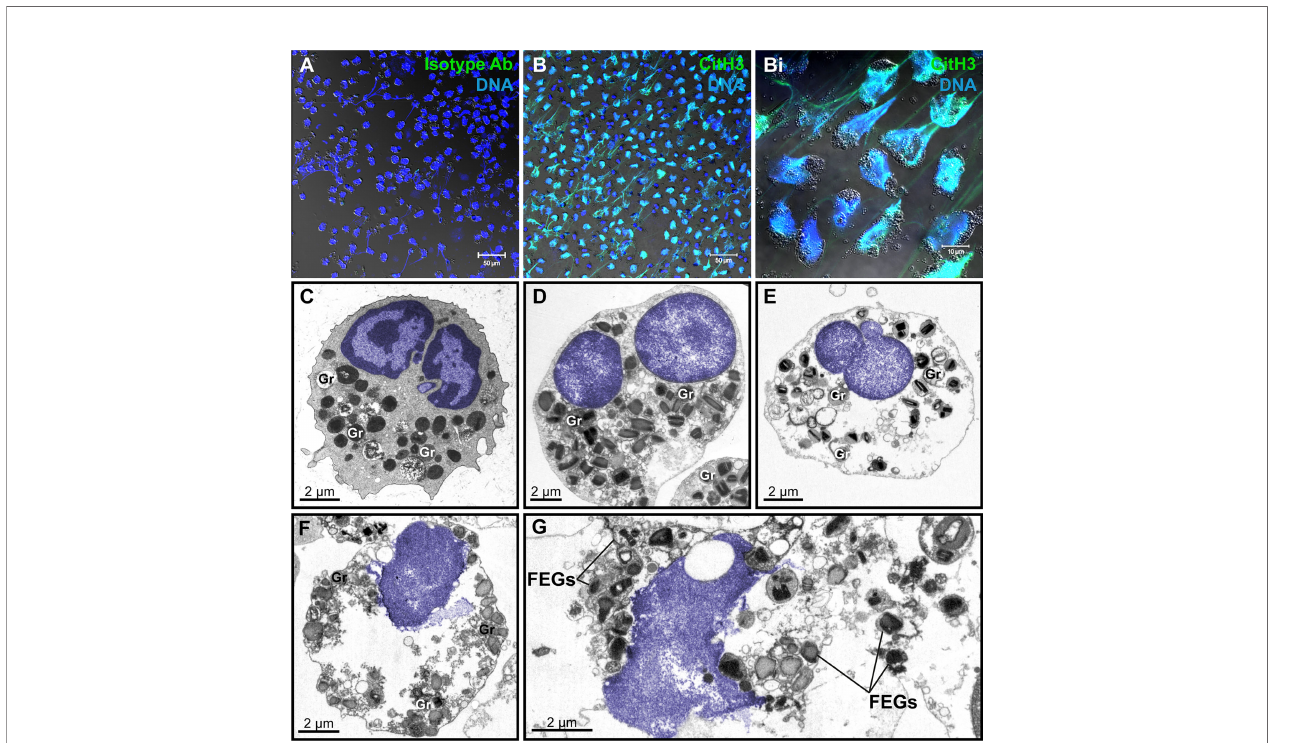
FIGURE 2 | Human eosinophil ETosis observed in vitro after stimulation. (A, B) Immuno fl uorescence staining for isotype (A) or anti-citrullinated H3 histone (CitH3) antibodies (green). EETs and CitH3 are colocalized as seen by confocal fl uorescence microscopy after staining for DNA (Hoechst, blue) and CitH3 (green). (Bi) Merged images of CitH3 + DNA-stained eosinophils in higher magni fi cation. Differential interference contrast (DIC) images were obtained by confocal microscopy. Puri fi ed eosinophils were stimulated with PAF + IL-5 followed by fi xation after 180 min. (C) Representative micrograph of an intact control eosinophil, stimulated with IL-5 alone, displaying a typical bilobed nucleus (colored in blue) with clear distinction between euchromatin and heterochromatin. (D – G) Ultrastructural alterations displayed by human eosinophils in process of ETosis after stimulation. Decondensation, delobulation, and rounding are observed. In (F, G) , the nuclear envelope is partially disrupted and chromatin is being released as extracellular traps. Free extracellular granules (FEGs) are deposited in the extracellular medium. Samples were prepared for TEM. Nucleus and extracellular chromatin are colored in blue. Ab, antibody; Gr, secretory